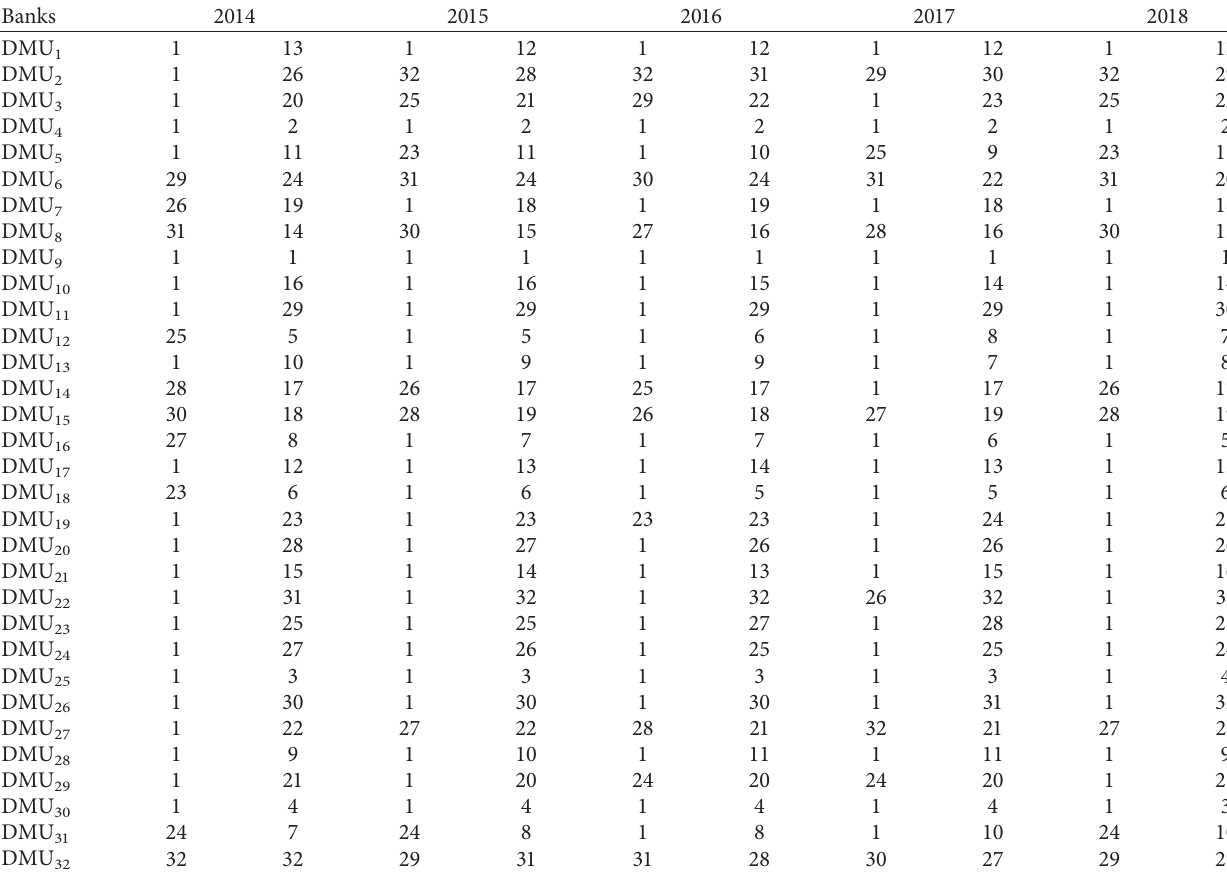
Table 9: Ranking of inefficiency and inefficiency dominance